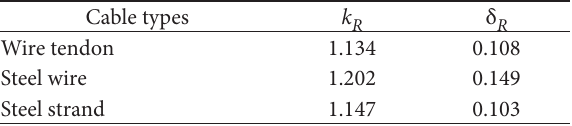
Table 7. Resistance statistical parameters of stay cable